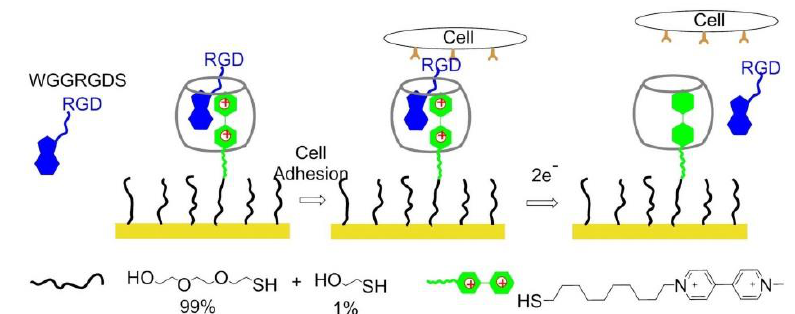
Figure 21. Electrochemically controlled polymers on the surface. The WGG-viologen-CB[8] complex is immobilized on the gold surface when viologen gets 2 electrons, and WGGRGDS is released from the complex.